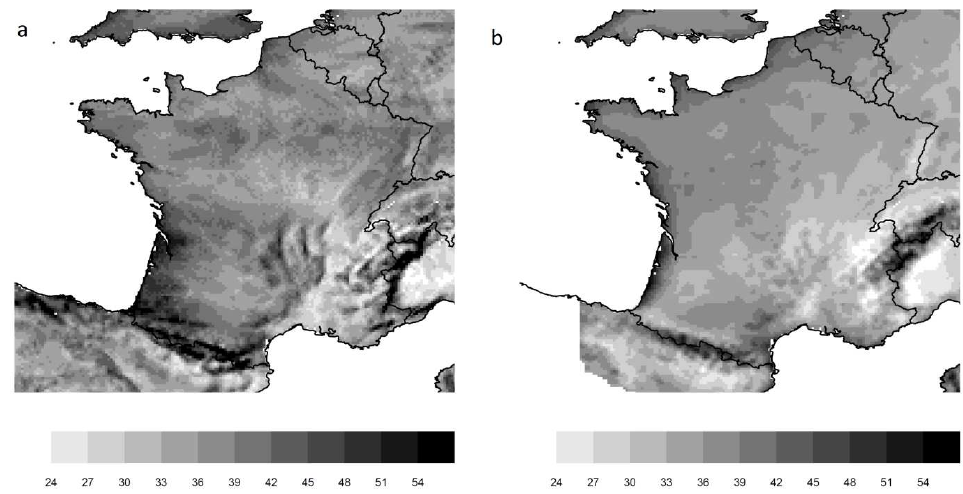
Fig. 8 Circa 50-year return level of wind gust (m s -1 ) for the a) historical (rank 1 grid-point wind Fig. 8. Circa 50-yr return level of wind gust (ms − 1 ) for the (a) historical (rank 1 grid-point wind speed) and (b) RCM (mean rank 1 grid-point wind speed) storm speed) and b) RCM (mean rank 1 grid-point wind speed) storm sets.